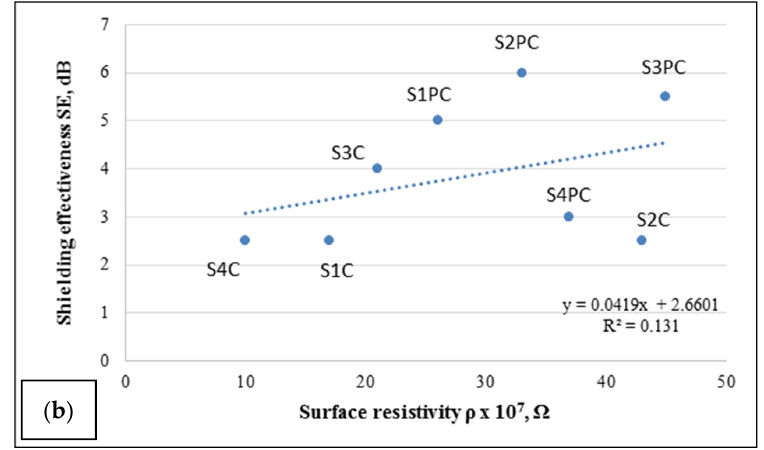
Figure 5. Dependence of surface resistivity on shielding effectiveness: ( a ) unwashed samples; ( b ) samples after washing.